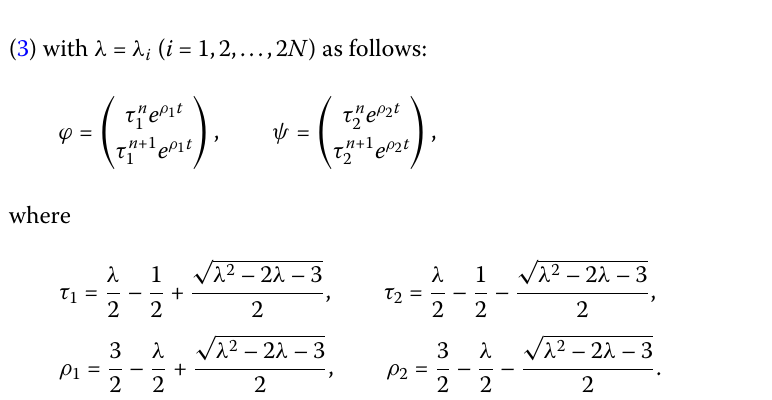
Figure 12 Collisions of four-soliton solutions (cid:8) u n and (cid:8) v n in (50) with N = 2 via the parameters r 1 = 1 r 3 = 1, r 4 = –1, λ 1 = –3, λ 2 = – 5 as an initial condition; ( c ) Time evolution using exact solution perturbed by a 2% noise as the initial